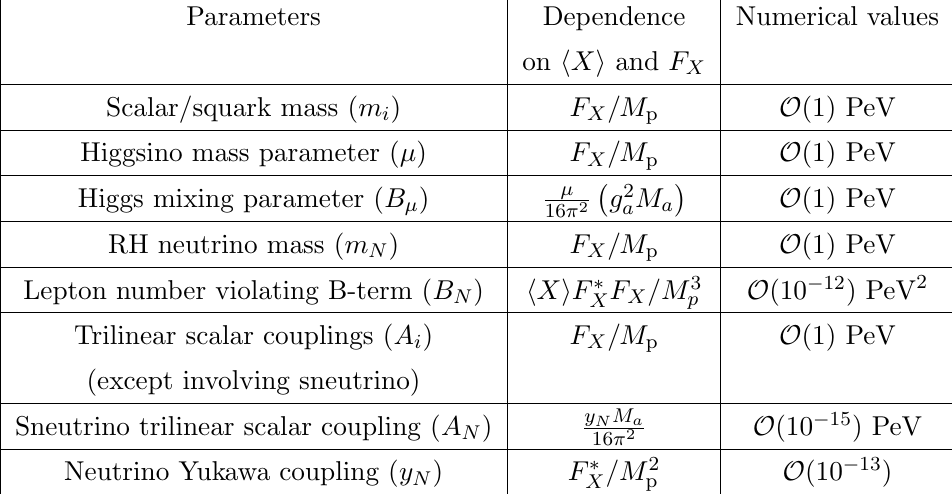
Table 1 . Table showing the order-of-magnitude of the SUSY breaking parameters and the RH neutrino/sneutrino couplings in our model. Note that all parameters must be evaluated at the SUSY breaking scale and must be renormalization group (RG) evolved to the low energy scale to (cid:12)nd their physical values. While we expect only an O (1) change in most parameters, the only term that gets a large loop correction from RG evolution is the sneutrino trilinear scalar coupling A N . The values shown in the table re(cid:13)ect the RG evolved values of all parameters evaluated at the appropriate physical